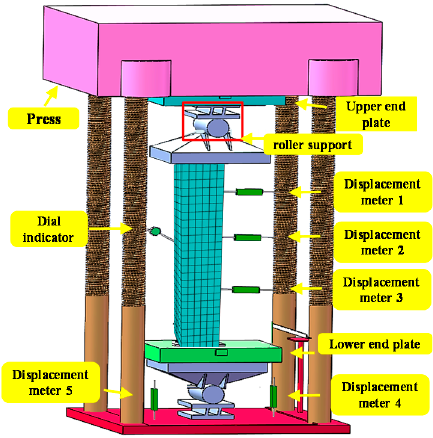
Figure 3. Test loading device.